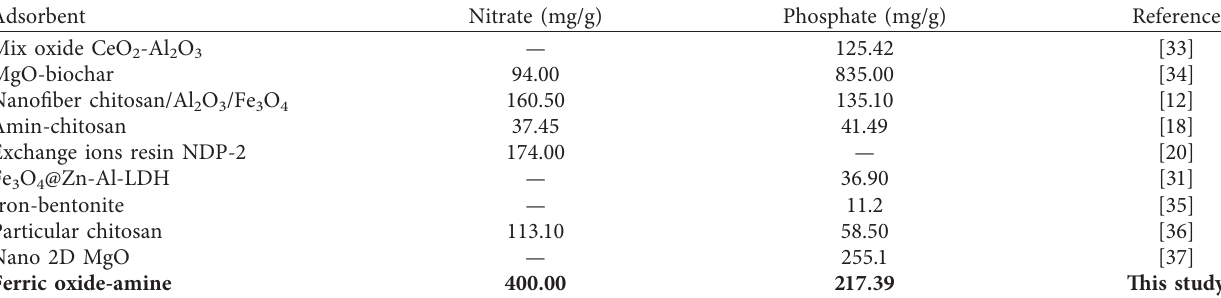
Table 3: A comparison between Q max in this study and previous research studies.